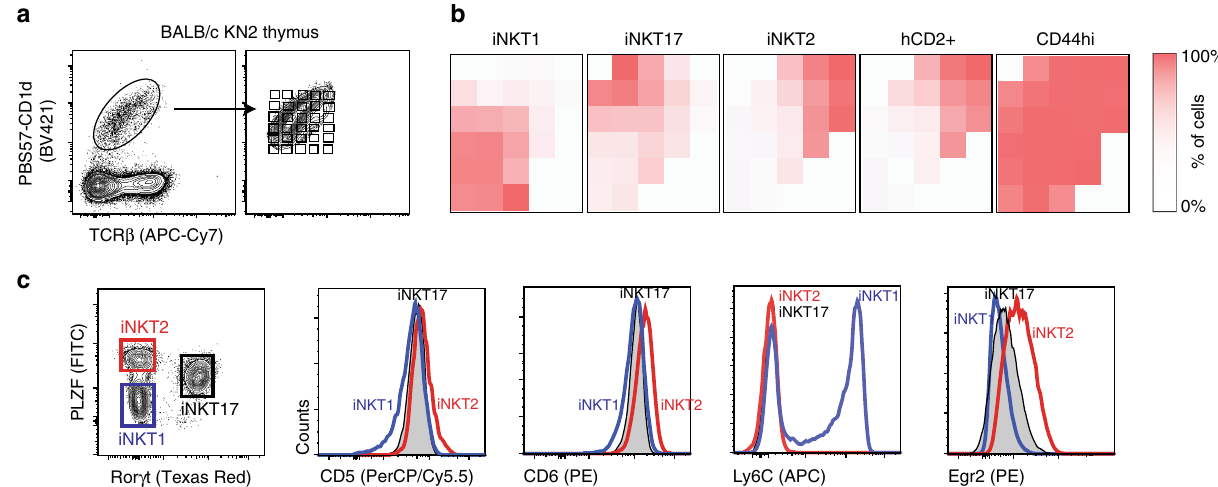
Fig. 1 Thymic iNKT subsets have different avidities for the PBS57 – CD1d tetramer that correlate with expression of surrogate markers re fl ective of strength of signaling during selection. a Cells from the thymus of BALB/c IL-4 reporter KN2 mice were stained with anti-TCR β mAbs and PBS57 – CD1d tetramers. iNKT cells were then electronically placed on a grid consisting of 30 gates, allowing for the analysis of iNKT cells expressing different TCR levels and/or different binding to the PBS57 – CD1d tetramer for a given level of TCR. b The proportion of iNKT1 (PLZF lo , Ror γ t − , Tbet + ), iNKT17 (PLZF int , Ror γ t + , Tbet − ), iNKT2 (PLZF hi , Ror γ t – , Tbet – , or hCD2 + ) as well as the proportion of CD44 hi cells in each gate was recorded and displayed as a heatmap. c Representative histograms for the expression of CD5, CD6, Ly6C, and Egr2 in each iNKT cell subset (as de fi ned by the gating strategy shown on the left) is shown. Data are representative of n > 3 mice for each